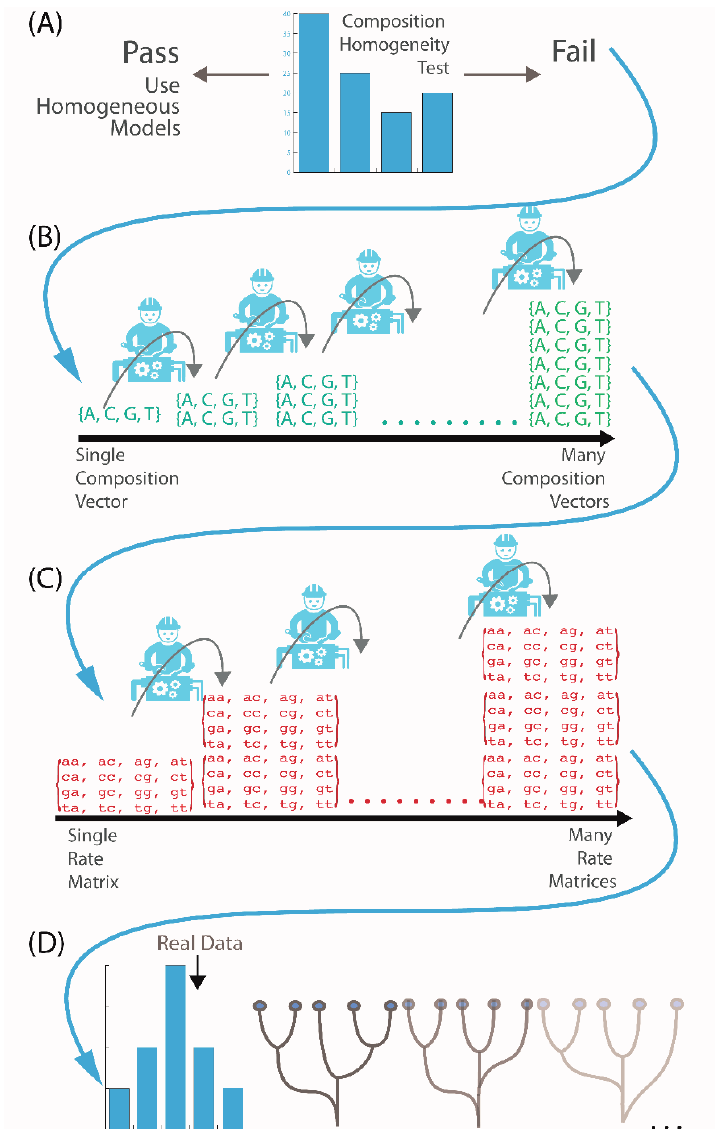
Figure 1. A flowchart of the steps involved in phylogenetic reconstruction using heterogeneous models. All the major steps we have described in performing a phylogenetic reconstruction using heterogeneous models are summarized here. ( A ) Starting with a multiple sequence alignment, the test for compositional homogeneity is carried out. Failing this test means the data must be modeled using a heterogeneous model. There are two phases to generating the heterogeneous model of best fit in P4 these are depicted in (B) and (C); ( B ) The first phase estimates the number of composition vectors needed for the dataset; ( C ) The second phase estimates the number of exchange rate matrices; ( D ) Depicts the assessment of the model adequacy using posterior predictive simulations and the generation of the trees from which a consensus tree is